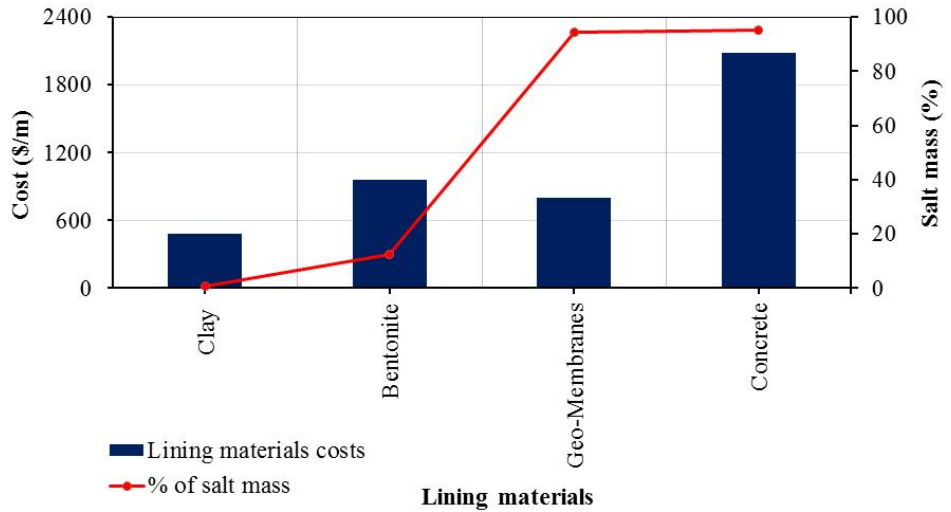
Figure 11. Total cost for different lining materials and the percentage of salt mass.